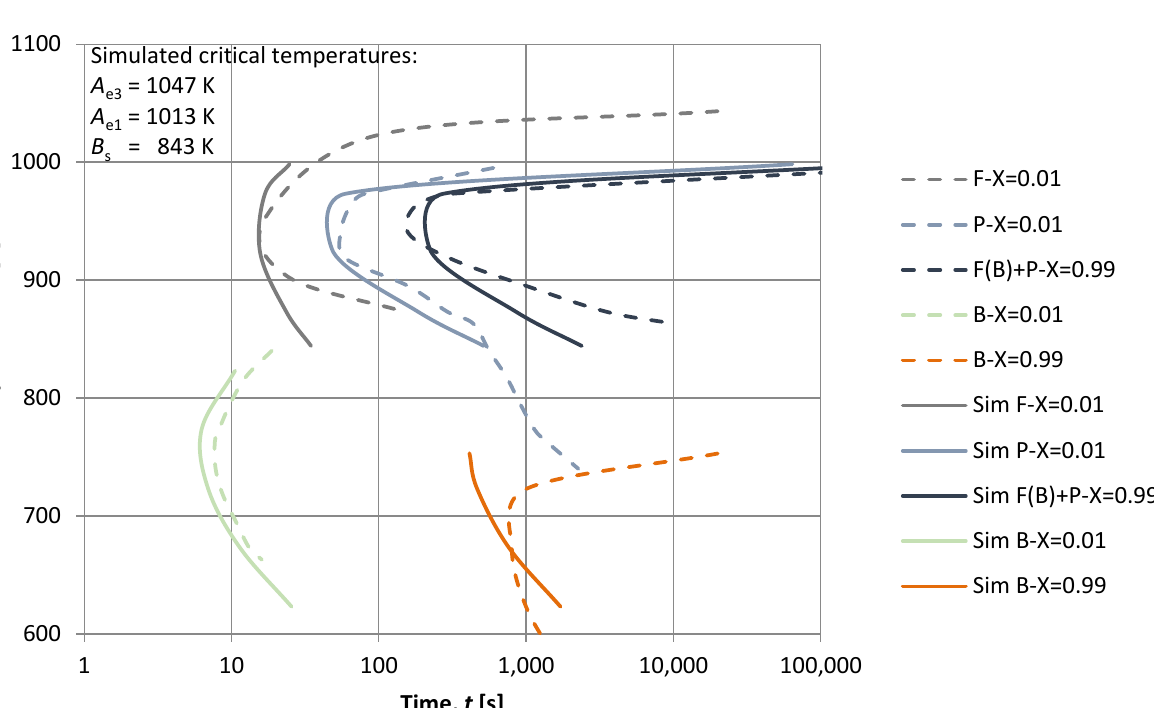
Figure 2. IT diagram of steel 42CrMo4.